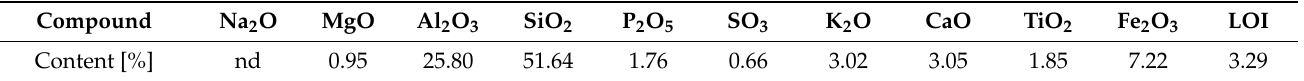
Table 1. Chemical composition of fly ash.